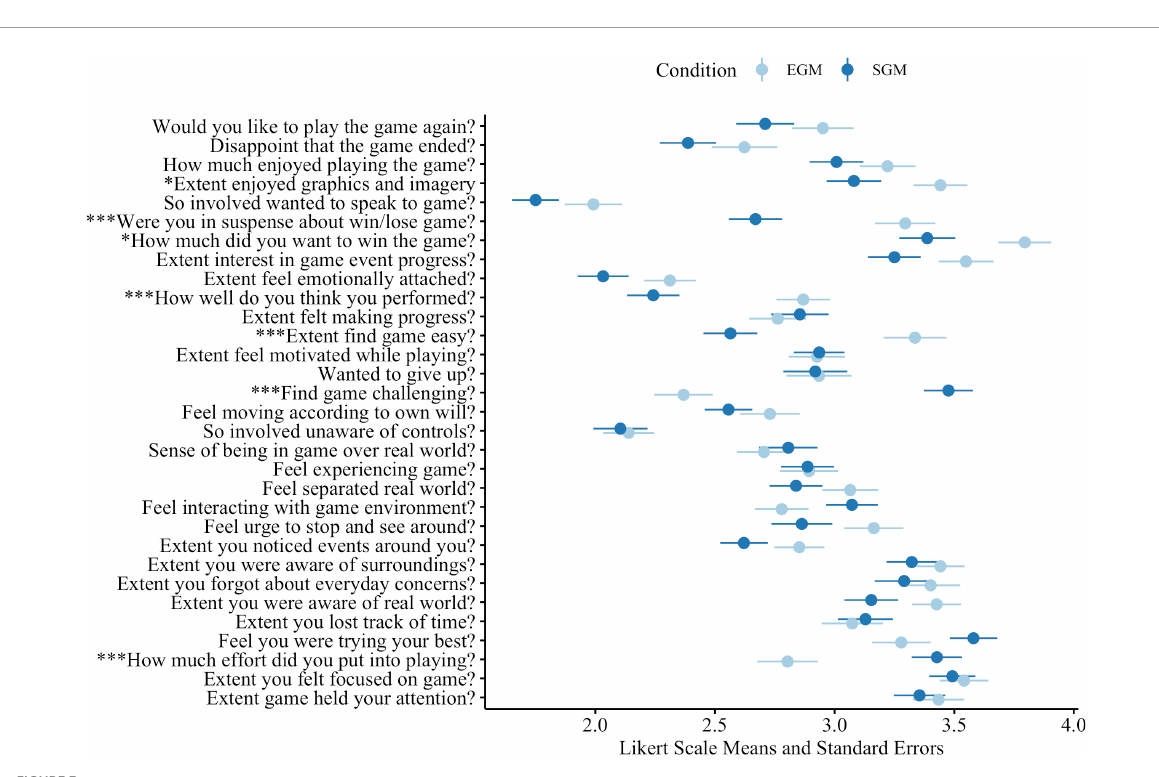
FIGURE3 Immersion questionnaire item mean responses based on EGM/SGM assignment condition. * p < 0.05, ** p < 0.01, *** p <